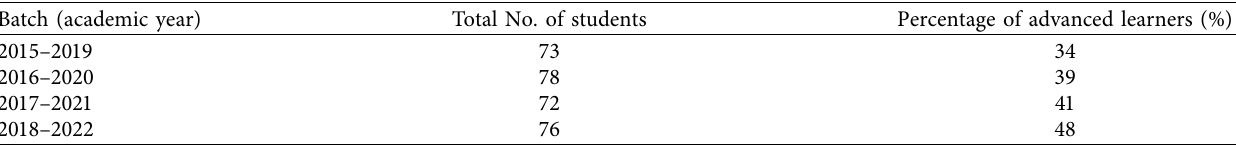
Table 6: Summary of pedagogical interventions concerning the academic year. Batch (academic year) Total No. of